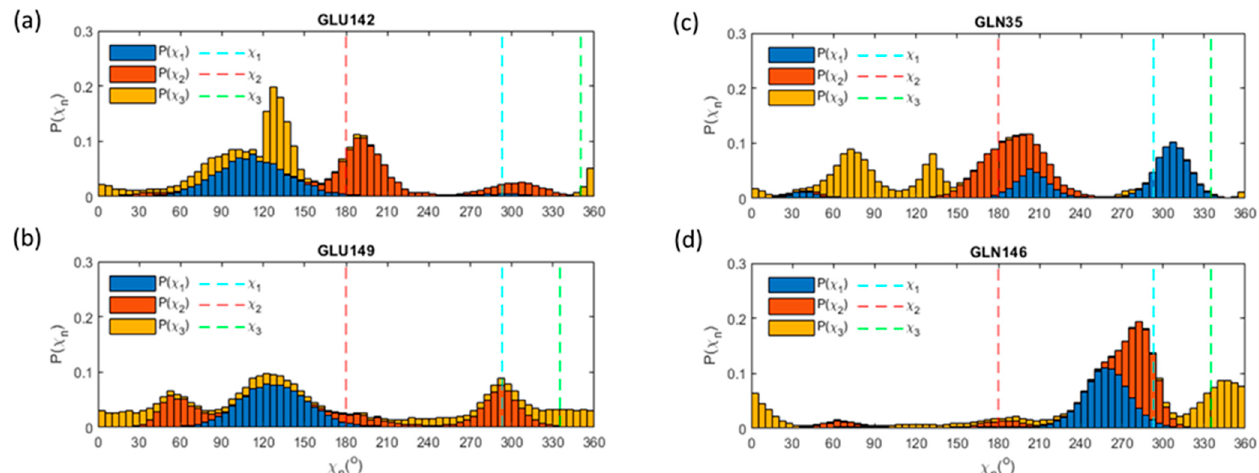
Figure 7. Stacked bar graph of side-chain χ 1 , χ 2 , χ 3 torsions probability distributions for Glu142, Glu149 ( a , b ), and Gln35, Gln146 ( c , d ). The probability values within 5 ◦ × 5 ◦ bins for separate torsion angles were marked as blue, orange, and yellow, respectively. Appropriate values of χ 1 , χ 2 , χ 3 angles from the experimental Hyp-1 model were presented sequentially as light blue, orange, and light green dashed lines.